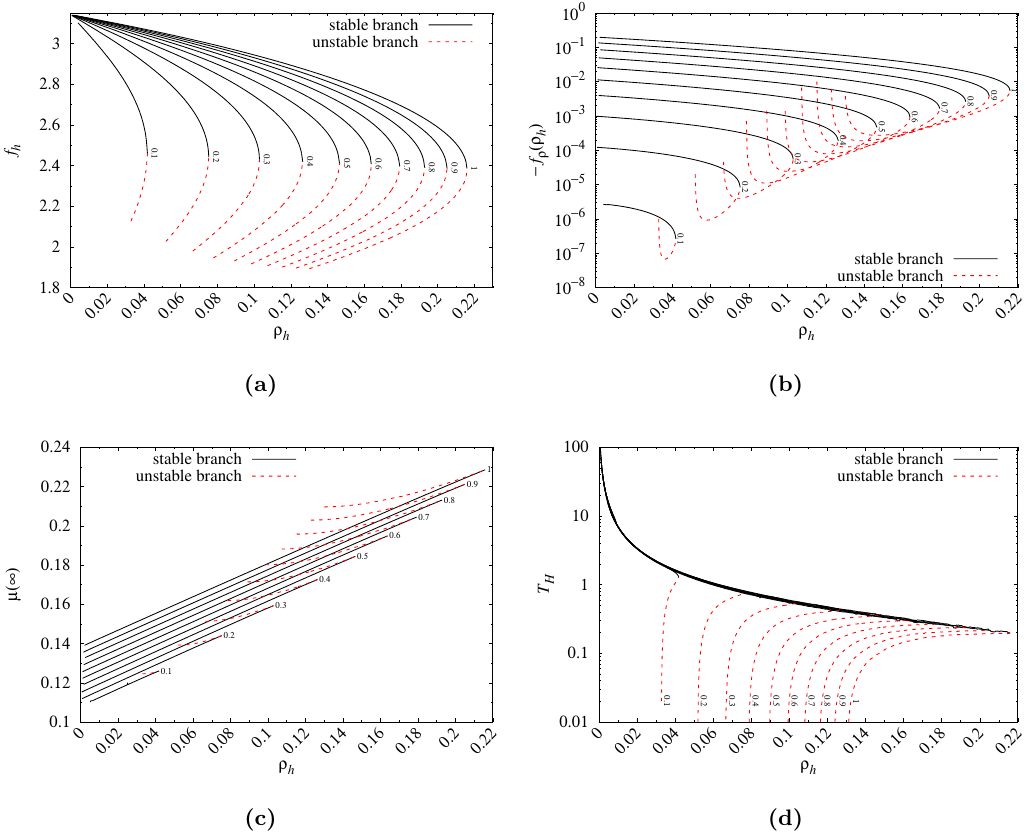
Figure 8 . Stable (black solid lines) and unstable (red dashed lines) branches of solutions in the 2 + 4 + 10 model: (a) the value of the pro(cid:12)le function at the horizon, f h ; (b) the derivative of the pro(cid:12)le function at the horizon, f (cid:26) ( (cid:26) h ); (c) the ADM mass, (cid:22) ( 1 ); (d) the Hawking temperature T H , all as functions of the size of the black hole, i.e. the horizon radius, (cid:26) h . The numbers on the (cid:12)gures indicate the di(cid:11)erent values of (cid:12) = 0 : 1 ; 0 : 2 ; : : : ; 1. From (cid:12)gures 8(b) and 9(b), we can see that the derivative of the pro(cid:12)le function at